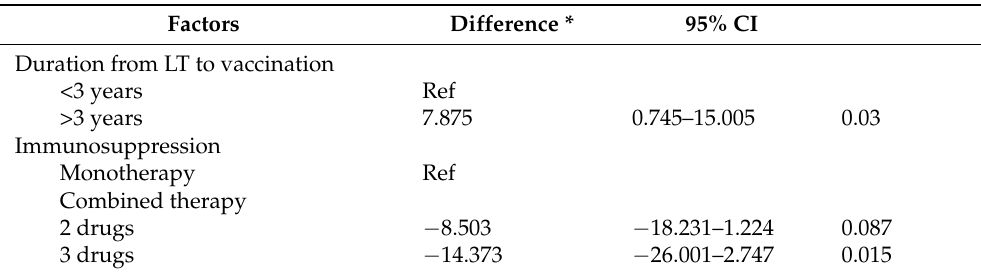
Table 3. Factors associated with sVNT to Omicron variant after BNT162b2 administration in multi- variate regression analysis.